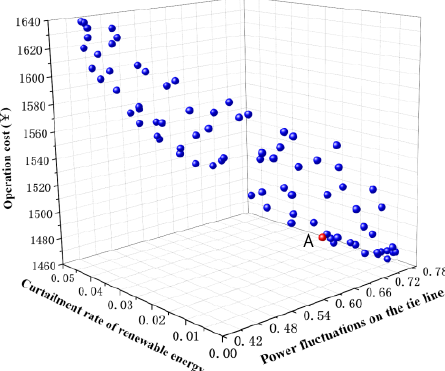
Figure 7. Three-objective non-dominated solution set based on the conventional strategy.